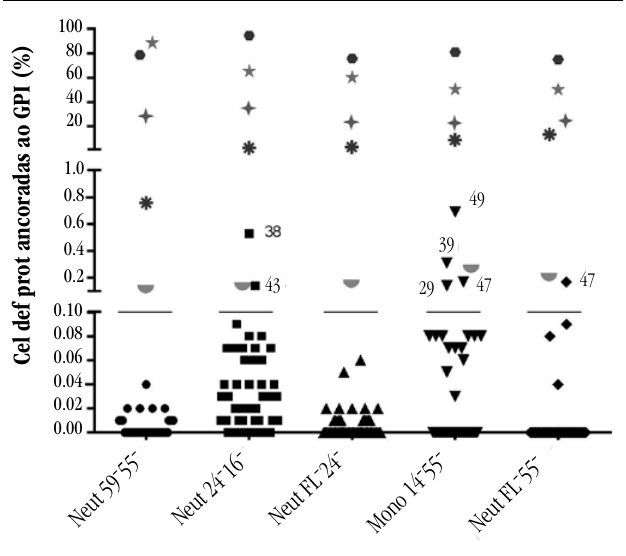
figurE 5 – Results obtained in the detection of GPI-anchored protein-deficient cells in samples from the control group and AA and MDS patients, by reagent combinations, in the populations of neutrophils and monocytes The black bar represents the cut-off point (0.1%) chosen for the detection of PNH cells. Patients with PNH clone are represented in colored symbols. Patients who present altered cells in proportions higher than 0.1% in isolated tubes, not characteristic of PNH clone, are represented by black symbols, above the bar, followed by the respective identification numbers of the databank GPI: glycosylphosphatidylinositol; AA: aplastic anaemia; MDS: myelodysplastic syndrome; PNH: paroxysmal nocturnal